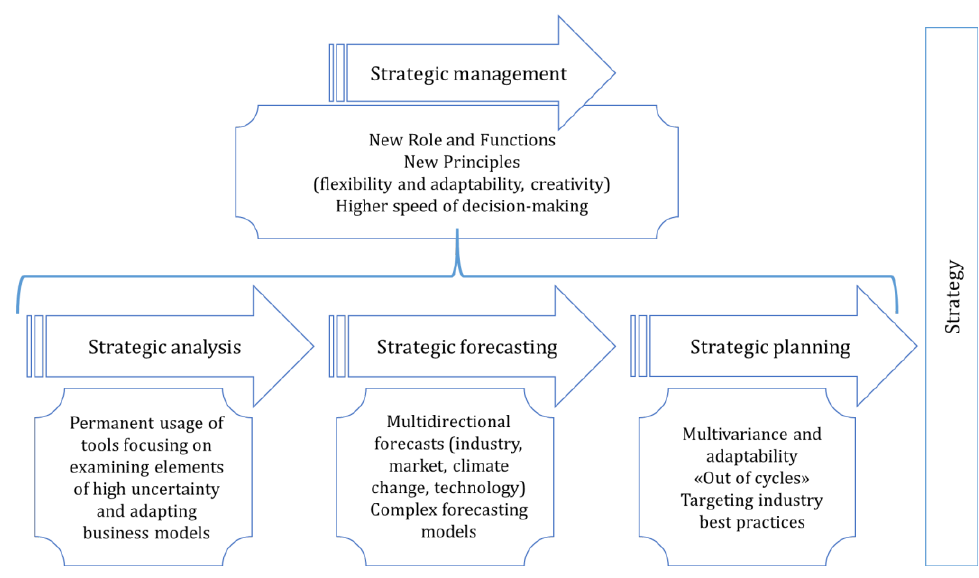
Figure 4. A conceptual vision of the basic transformation of strategic management systems of oil and gas companies. Source: Created by the authors.